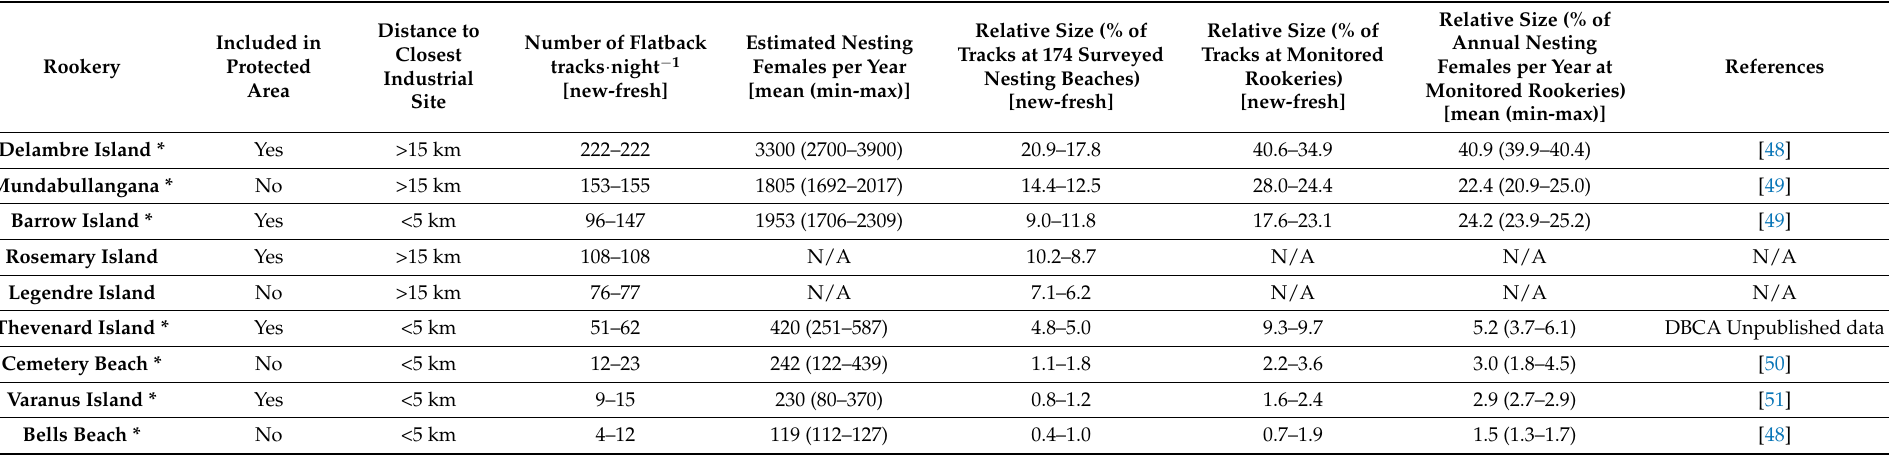
Table 2. Abundance, relative size, inclusion in protected area and distance to closest industrial site of nine flatback turtle rookeries in the Pilbara region of Western Australia. Seven of these rookeries (i.e., referred as ‘monitored rookeries’ in the table) were monitored annually during the flatback turtle nesting season (Nov–Dec). Numbers of new (<12 h old) and fresh (0–36 h old) flatback tracks per night were estimated via aerial photography captured between 29 November and 6 December 2016. Estimates of the mean, minimum and maximum number of nesting females per year at each of the monitored rookeries were obtained from unpublished reports or peer-reviewed publication (see column ‘References’). Number of flatback tracks from all 174 surveyed active nesting beaches: new = 1064; fresh = 1244; number of flatback tracks from the seven monitored rookeries: new = 547; fresh = 636; estimated number of nesting females per year at the seven monitored rookeries: mean = 8071, min = 6766, max = 9660. * indicates yearly monitoring. DBCA = Department of Biodiversity, Conservation and